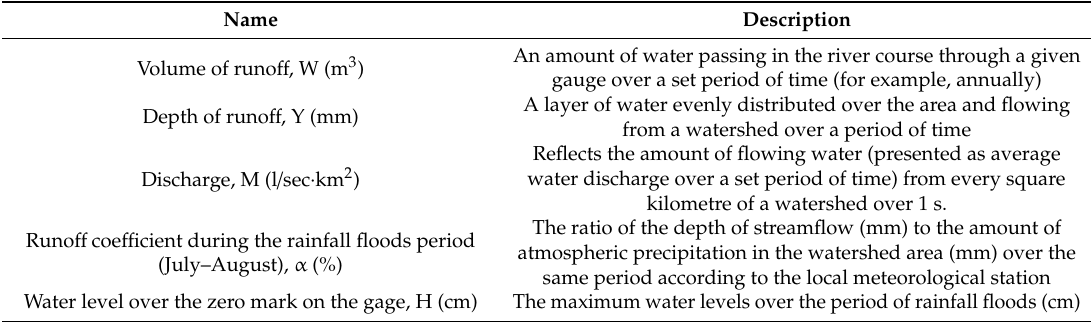
Table 2. Streamflow and water level